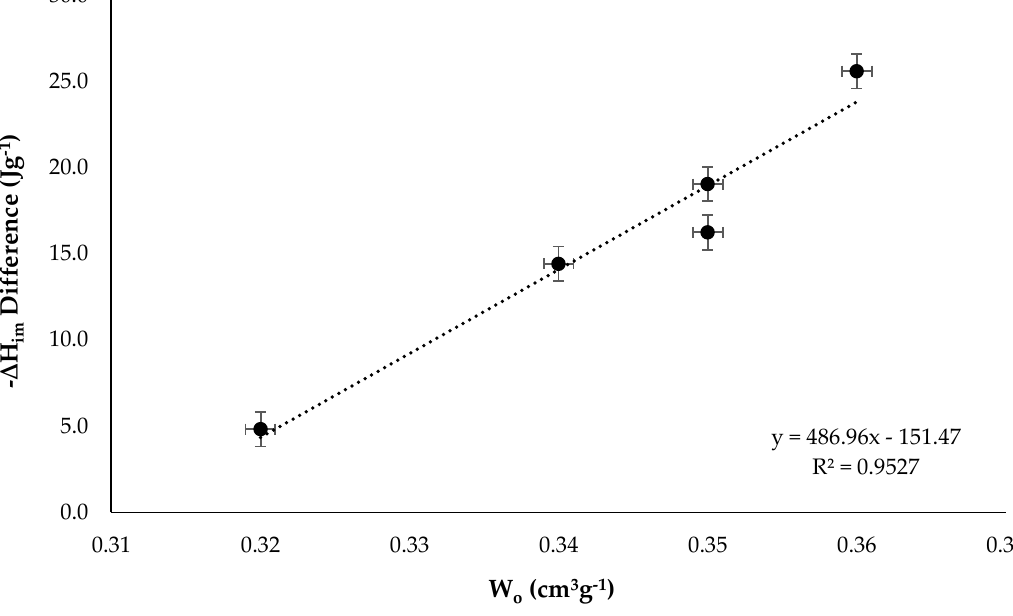
Figure 5. Difference between the immersion enthalpy cyclohexane and hexane in function of the micropore volume.